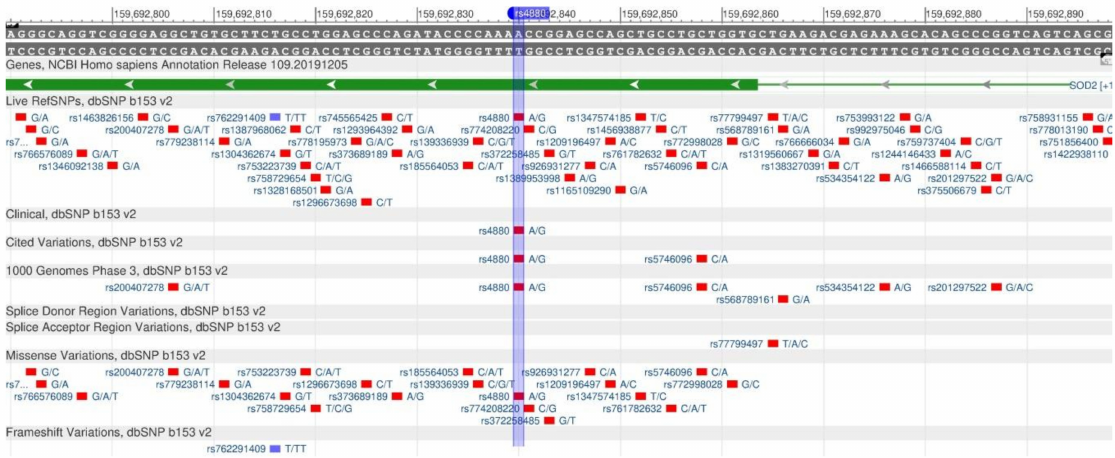
Figure 30. A portion of the MnSOD gene (located on the long (q) arm of chromosome 6) containing the oligonucleotide polymorphism rs4880.